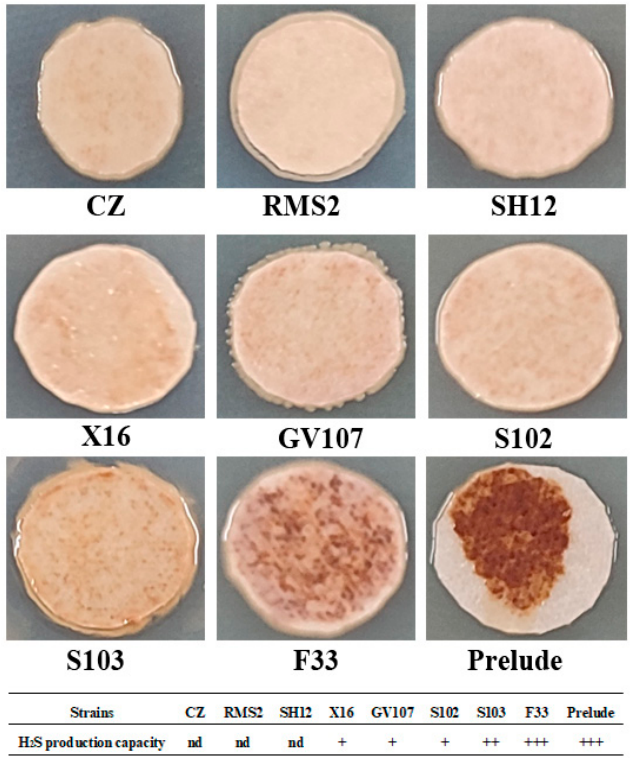
Figure 3. H 2 S production capacity of yeast strains. In the table, the greater number of + indicated the stronger the H 2 S production capacity, and nd indicates no obvious H 2 S detection.